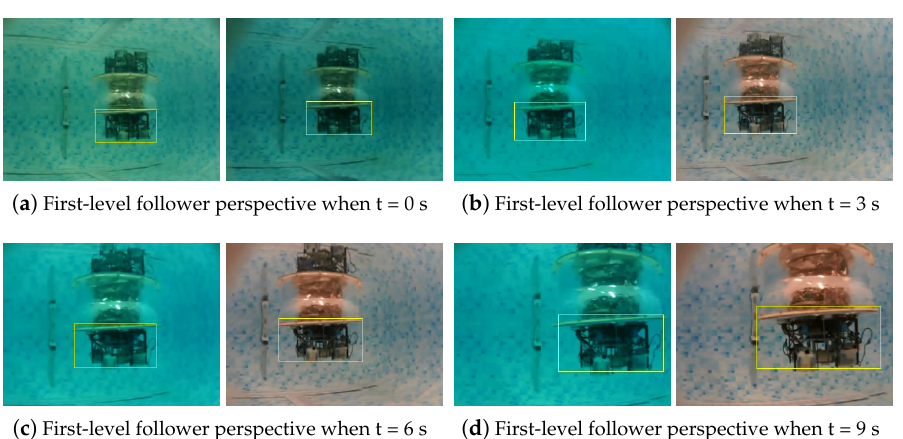
Figure 21. Images of first-level follower perspective and follower perspective of the three-robot “V-type escort” following formation